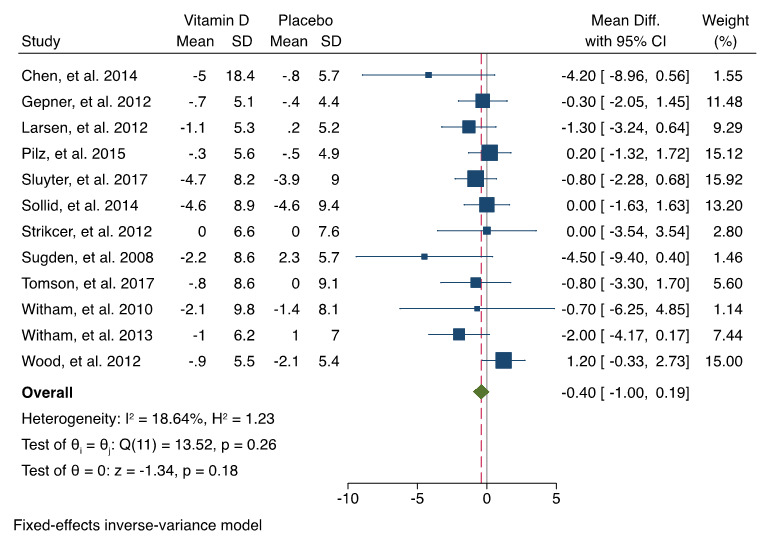
Forest plot of diastolic blood pressure changes from the baseline.The overall effect size estimate is represented by the red dashed line. CI, confidence interval; SD, standard deviation.